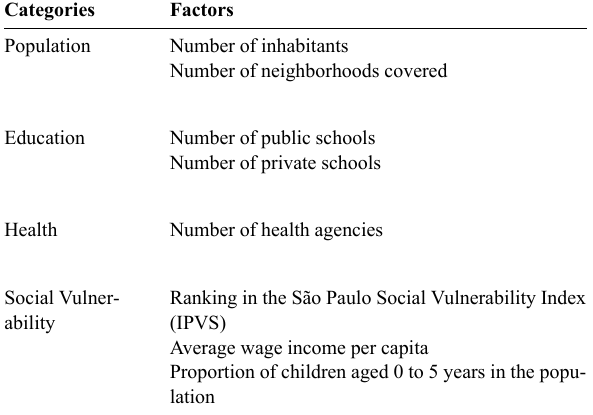
Table 2 - Categories and factors of georeferential analysis. Source: own